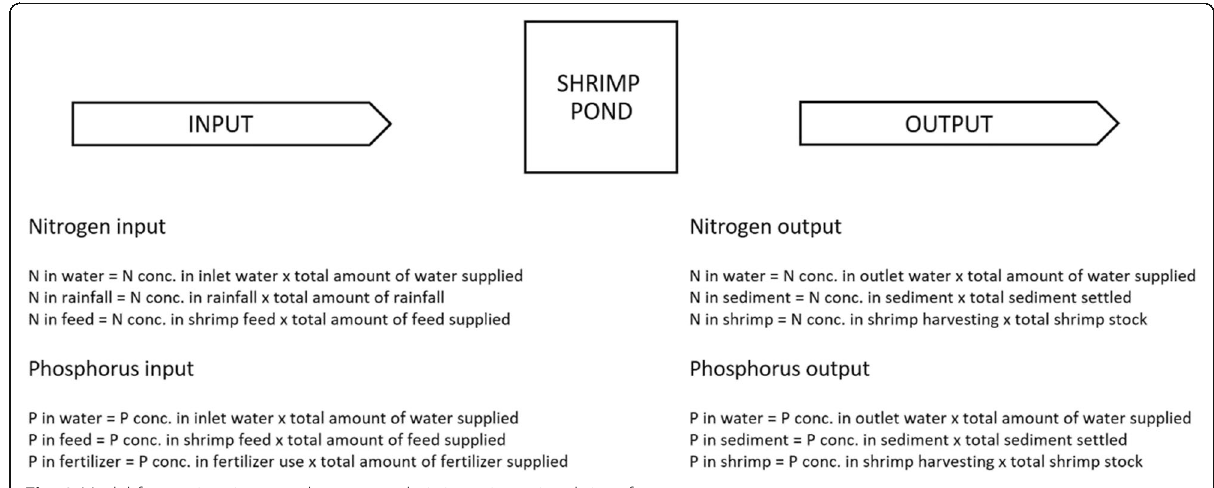
Fig. 2 Model for nutrient input and output analysis in an intensive shrimp